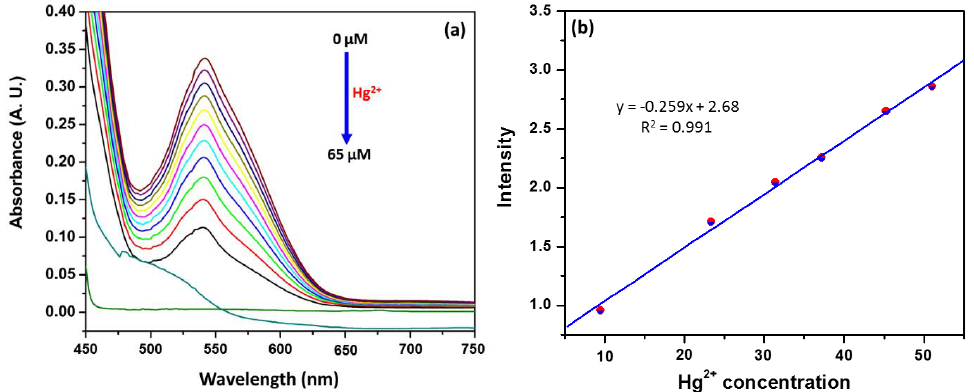
Figure 3. ( a ) Electronic absorption spectra of APD-AgNPs solutions with various concentrations of Hg 2+ in the range of 0 to 65 µM L − 1 increasing in steps of 5 µM L − 1 . ( b ) Linear relationship between the absorbance intensity of APD-AgNPs versus Hg 2+ ion concentration at 538 nm.